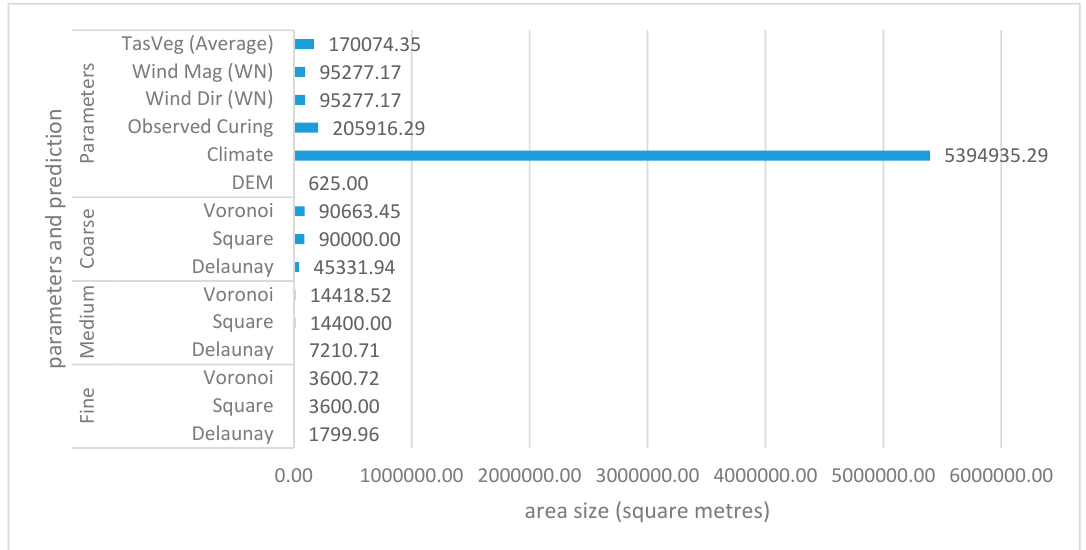
Figure 4. Area sizes of prediction and parameters.